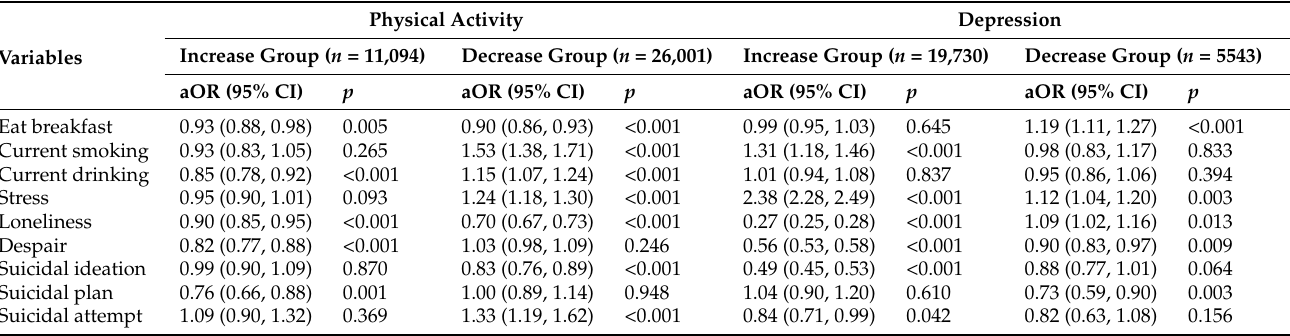
Table 4. Multinomial logistic regression for predictors of COVID-19 exchange physical activity and depression among adolescents ( n =